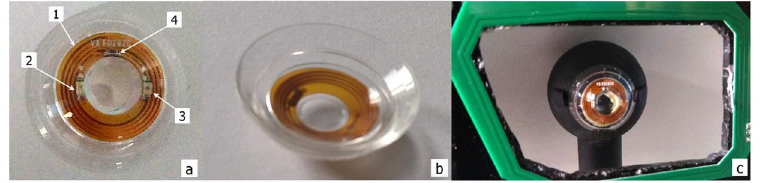
Fig 1. CLP presentation. a) VCSELs pair prototype (1: encapsulated circuit. 2: left VCSEL. 3: right VCSEL. 4: capacitor). b) Back side. c) CLP mounted on the mock-up eye behind the primary antenna (green element) in the